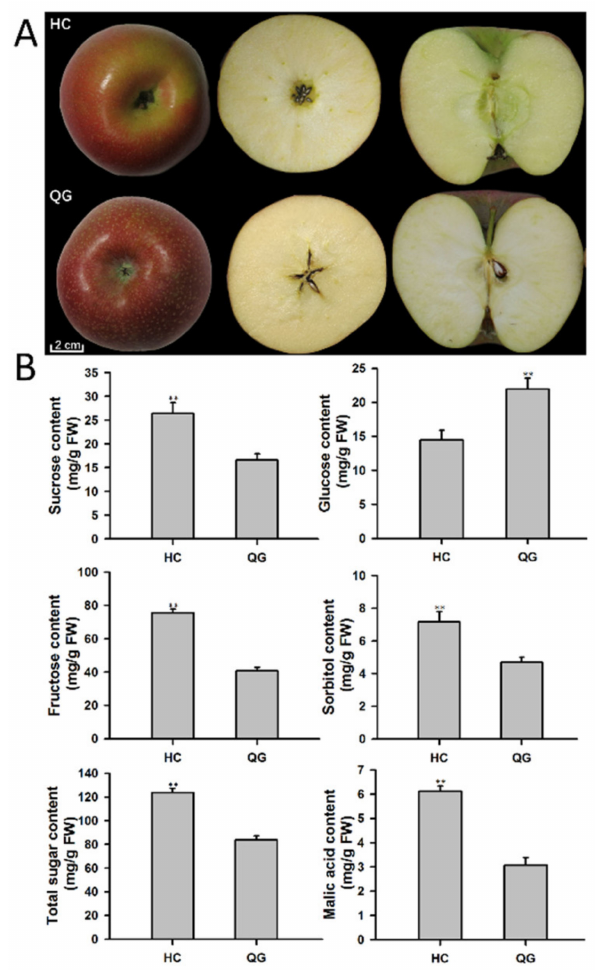
Figure 1. Phenotypes of ‘Honeycrisp’ (‘HC’) and ‘Qinguan’ (‘QG’) mature fruits. ( A ) Morphological characteristics of ‘HC’ and ‘QG’ mature fruits. ( B ) Soluble sugar and malic acid contents of ‘HC’ and ‘QG’ mature fruits. Double asterisks (**) represent significant differences between ‘HC’ and ‘QG’ mature fruits ( t -test, p <